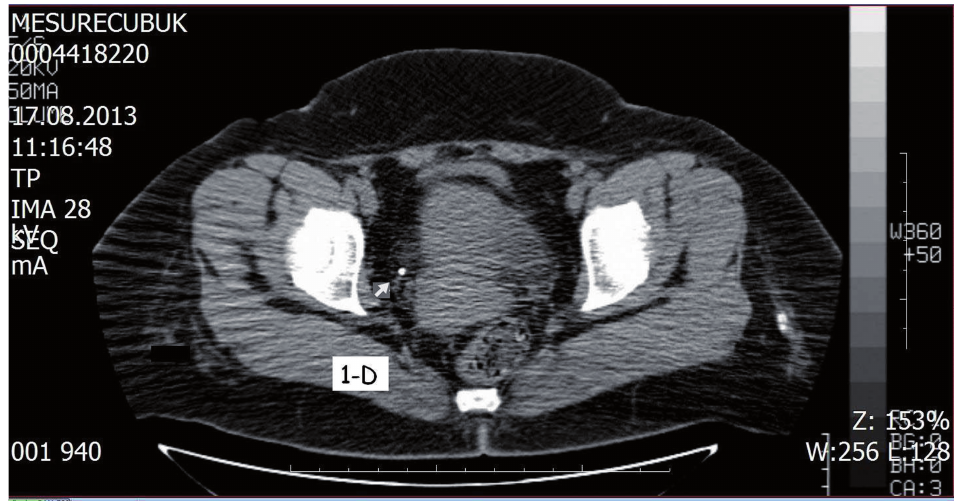
Figure 1d - CT image of endotacker migrated behind the bladder.